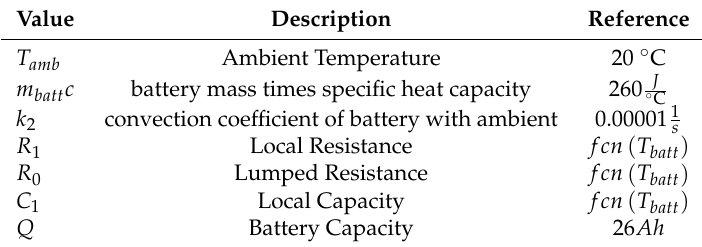
Table 6. Parameters and constants of the optimization